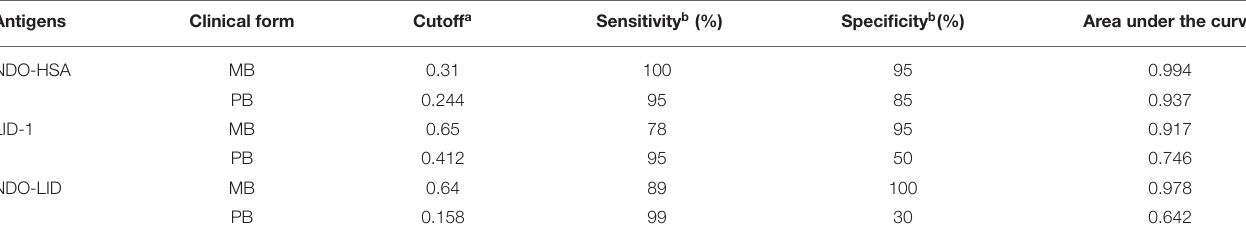
TABLE 2 | Sensitivity and specificity of NDO-HSA, LID-1 and NDO-LID antigens in IgA-based serodiagnosis of MB and PB leprosy.